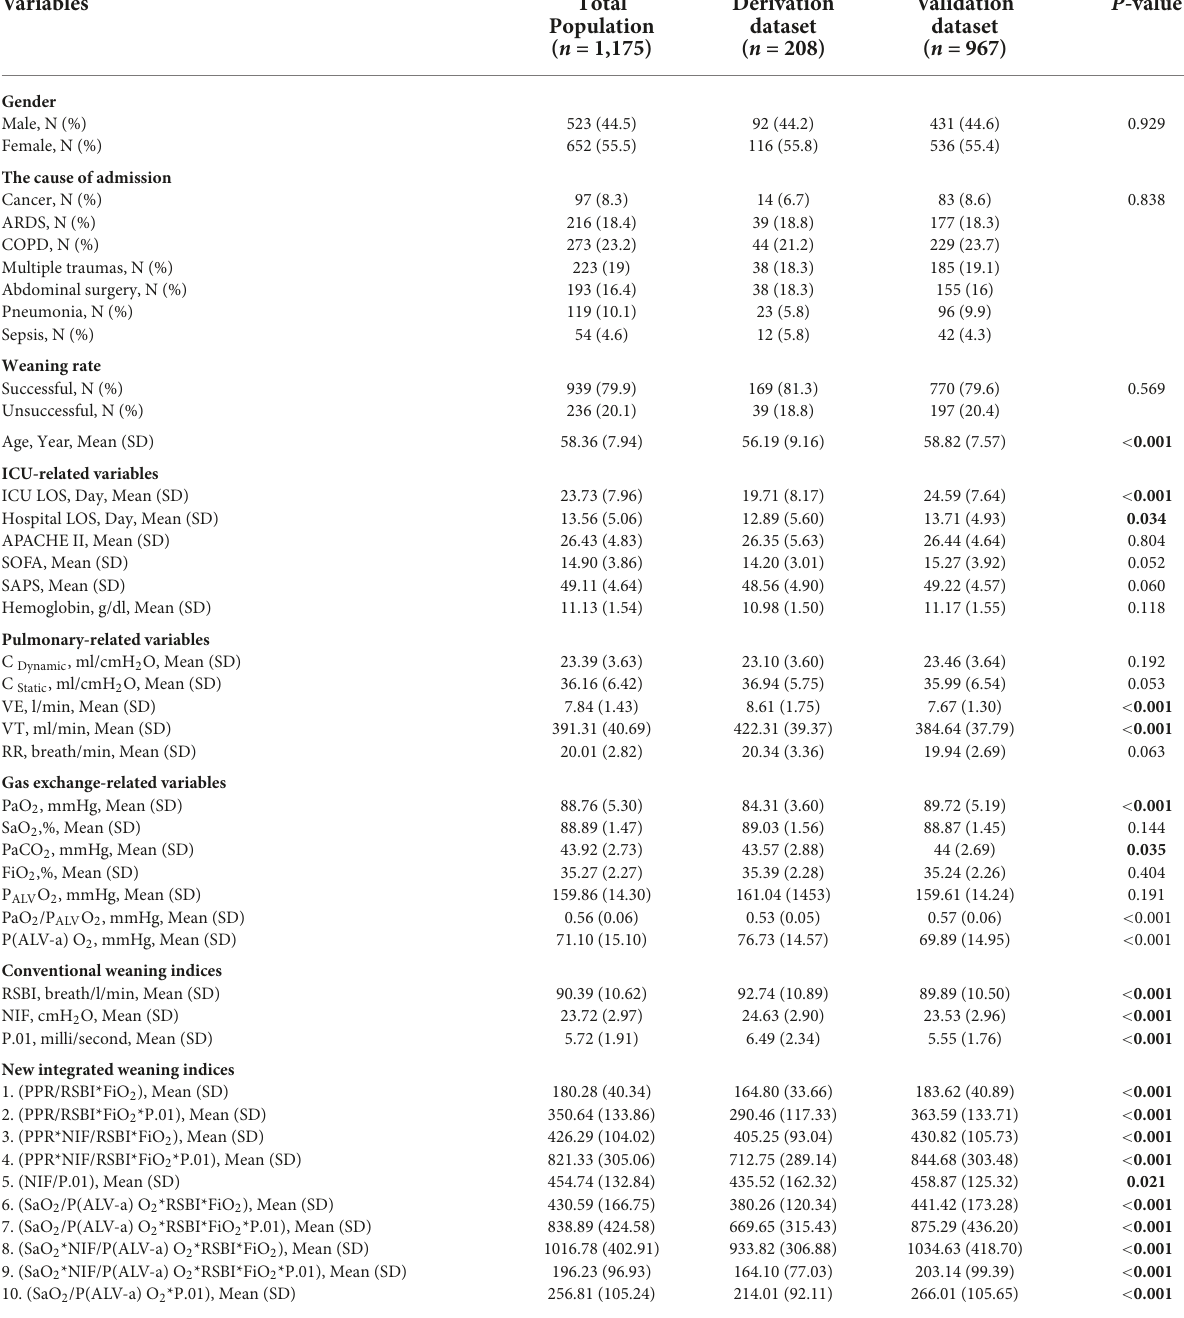
TABLE 1 Demographic data, clinical characteristics, incidence of successful and failure weaning in both derivation and validation groups and total population.